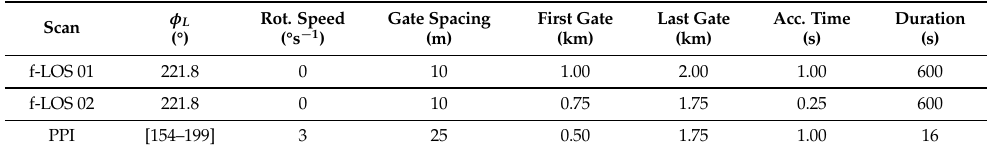
Table 1. Staring mode scans for Case 01 (f-LOS 01) and Cases 02[a–c] (f-LOS 02); and PPI mode scans for the reconstruction of the wind speed (WS) and wind direction (WD). The elevation angle is θ = 0° and the gate length L γ = 25